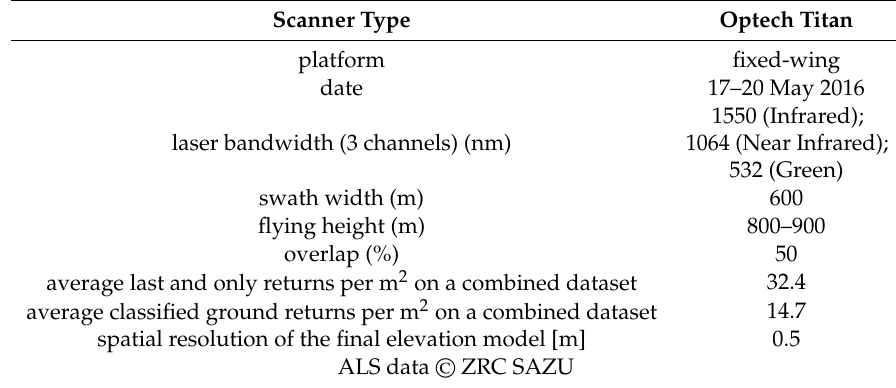
Table 1. ALS scanning parameters of the region around Chact ú n, Calakmul Biosphere Reserve, Campeche, Mexico.